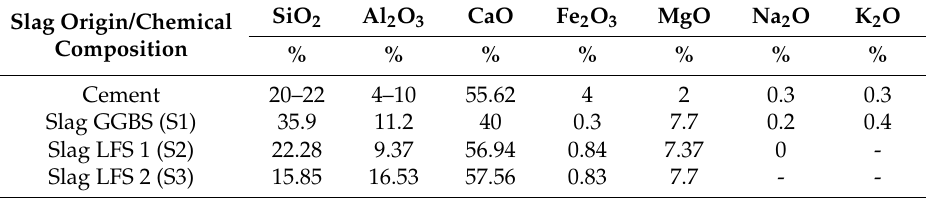
Table 1. Cement and slag chemical composition (data provided by the supplying company).